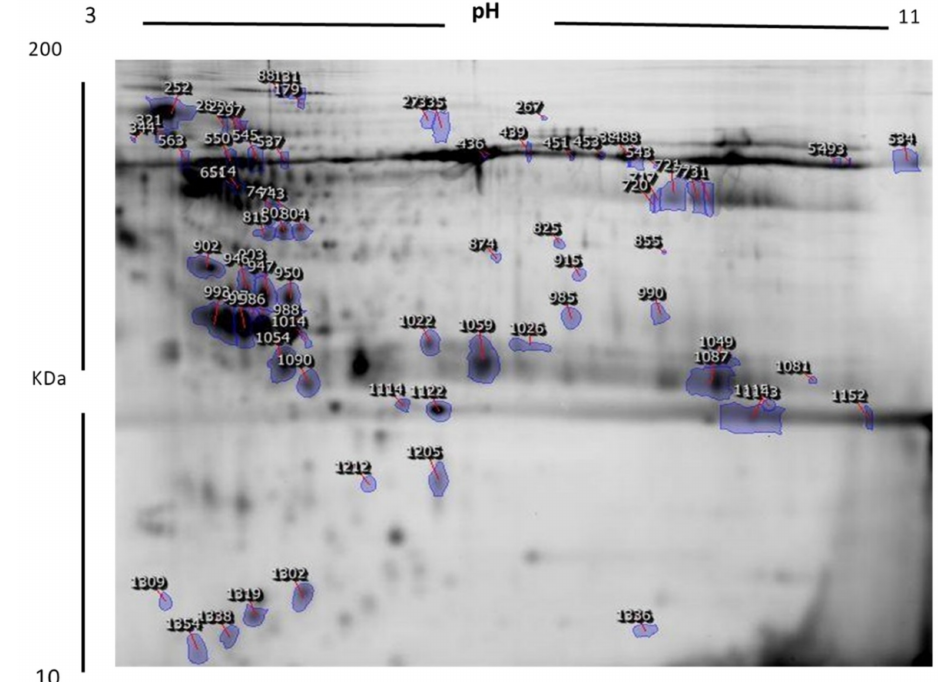
Figure 2. Representative image of protein spots from urine samples. Numbered spots indicate those which were identified with MALDI-TOF / TOF and were di ff erentially expressed (over 1.5-fold change, p <